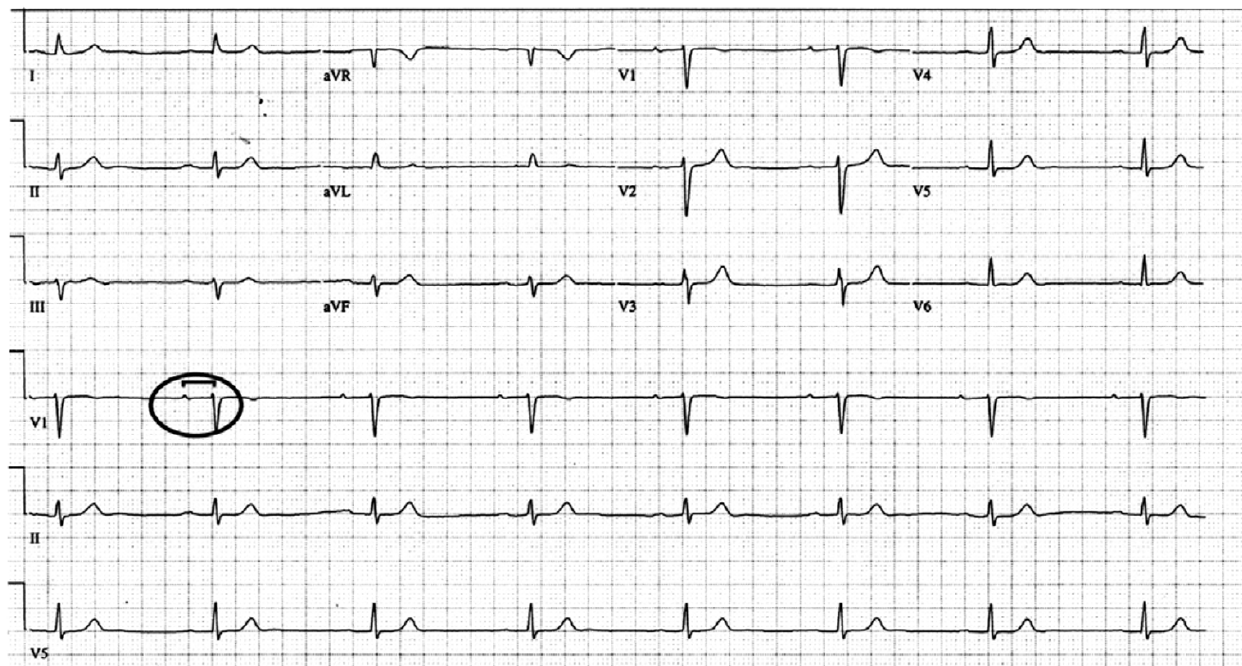
EKG Shown is the 12 lead electrocardiogram performed prior to pacemaker-defibrillator implantation. Each box represents 200 msec. Sinus bradycardia is present; the proband's baseline heart rate was 45 beats per minute (normal is 80 beats per minute). First degree atrioventricular heart block is present (circled) as the conduction time between the atrial deflection and the ventricular deflection is 240 msec (normal is up to 200